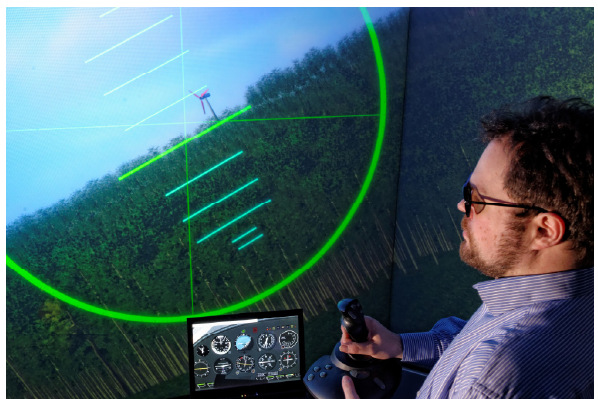
Figure 9. A flight simulator using a forest model as described